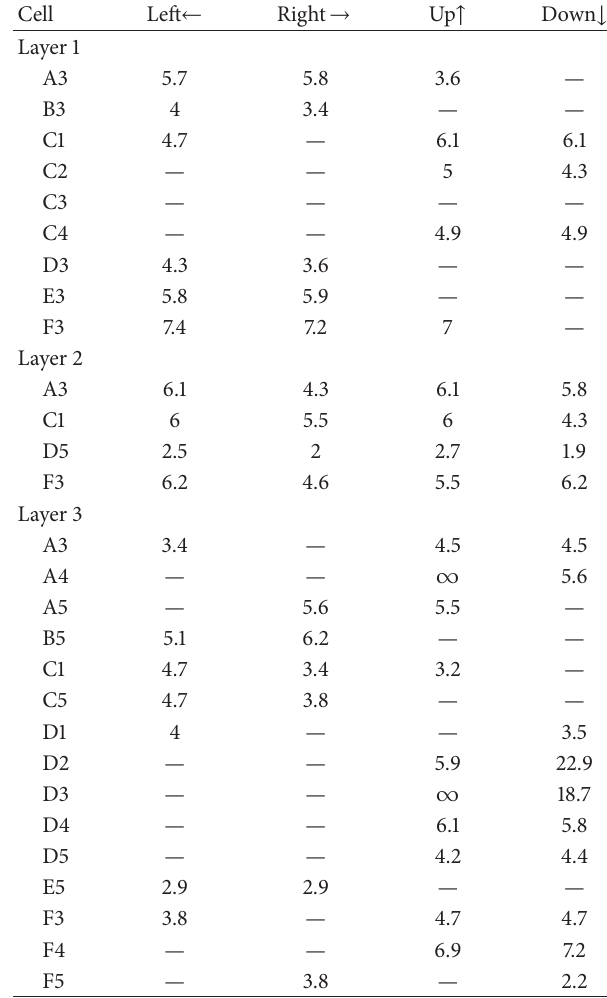
Table 2: Comparison of the recent 1-bit full adder. Design